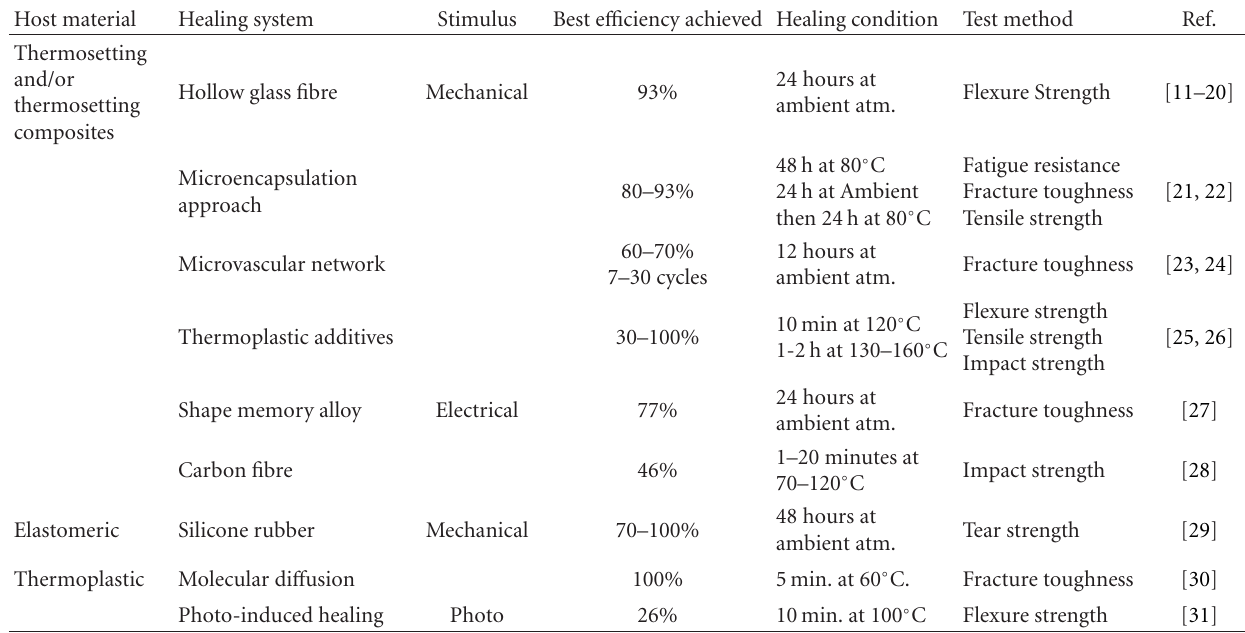
Table 1: Nonexhaustive main developments in self-healing polymer